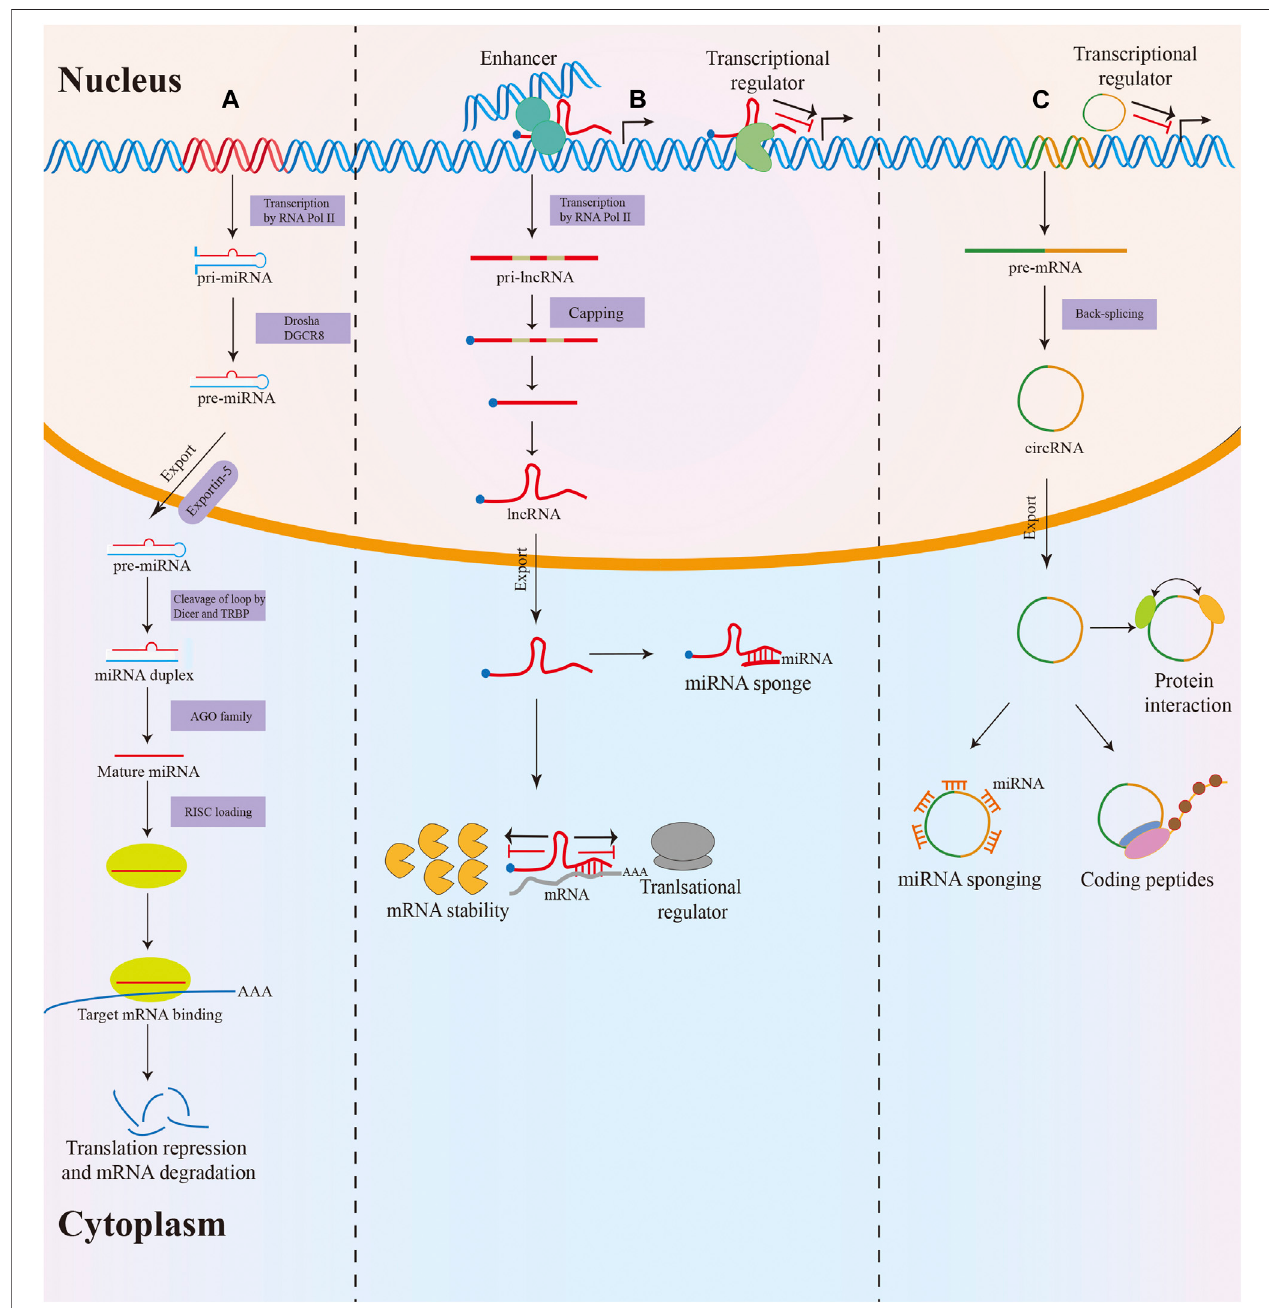
FIGURE 1 | Biogenesis and function of miRNA, lncRNA and circRNA. (A) MiRNAs are processed from stem-loop structures of longer RNA transcripts. Mature miRNAs are loaded into the RNA-induced silencing complex (RISC) to modulate target mRNA expression by degradation or translational repression. (B) Most lncRNAs transcribedbyRNApolymeraseIIarepolyadenylatedat 3 ′ ,5 ′ capped and spliced.LncRNAs act asdecoysorsponges fortranscriptionfactors ormiRNAs and serveas regulatorymolecules in epigenetic gene regulation,splicing, mRNA stability, and translation. (C) The majority ofcircRNAs are formed by back-splicing of precursor mRNAs (pre-mRNAs). CircRNAs exert their function via various mechanisms, including miRNA sponging, translation into proteins, interacting with proteins, and regulating their function.